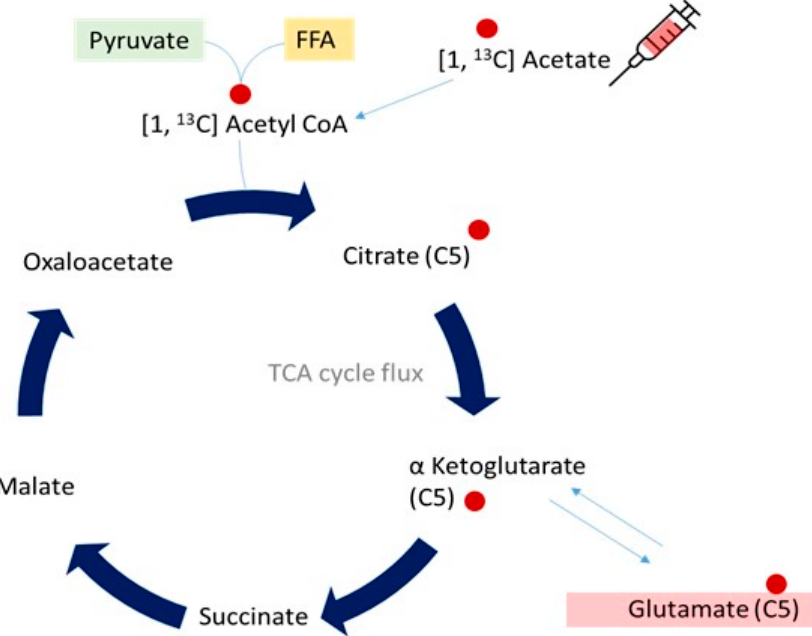
Figure 6. Schematic diagram demonstrating the fate of infused 13 C labelled acetate upon incorpo- ration into hepatic metabolism. Following degradation to 13 C Acetyl CoA, fractional enrichment of hepatic 13 C glutamate (with the 13 C nucleus at the C5 position) is measurable on the MR visible spectrum, enabling calculation of TCA cycle flux.